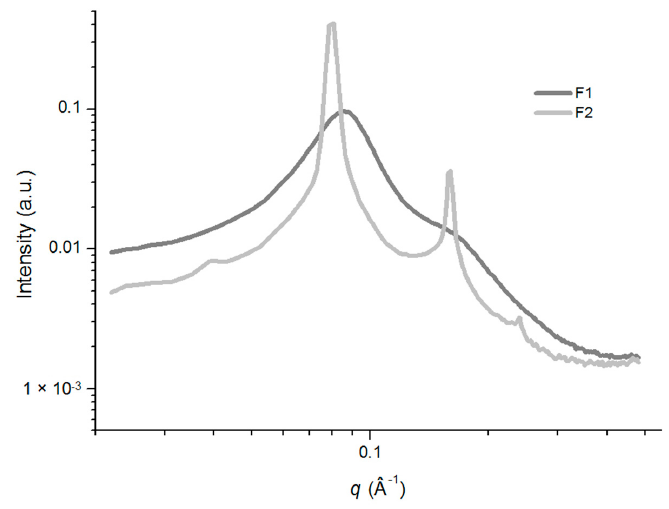
Figure 4. Small-angle X-ray scattering (SAXS) patterns of samples F1 and F2 without KSL-W. Data were collected at 25 °C.